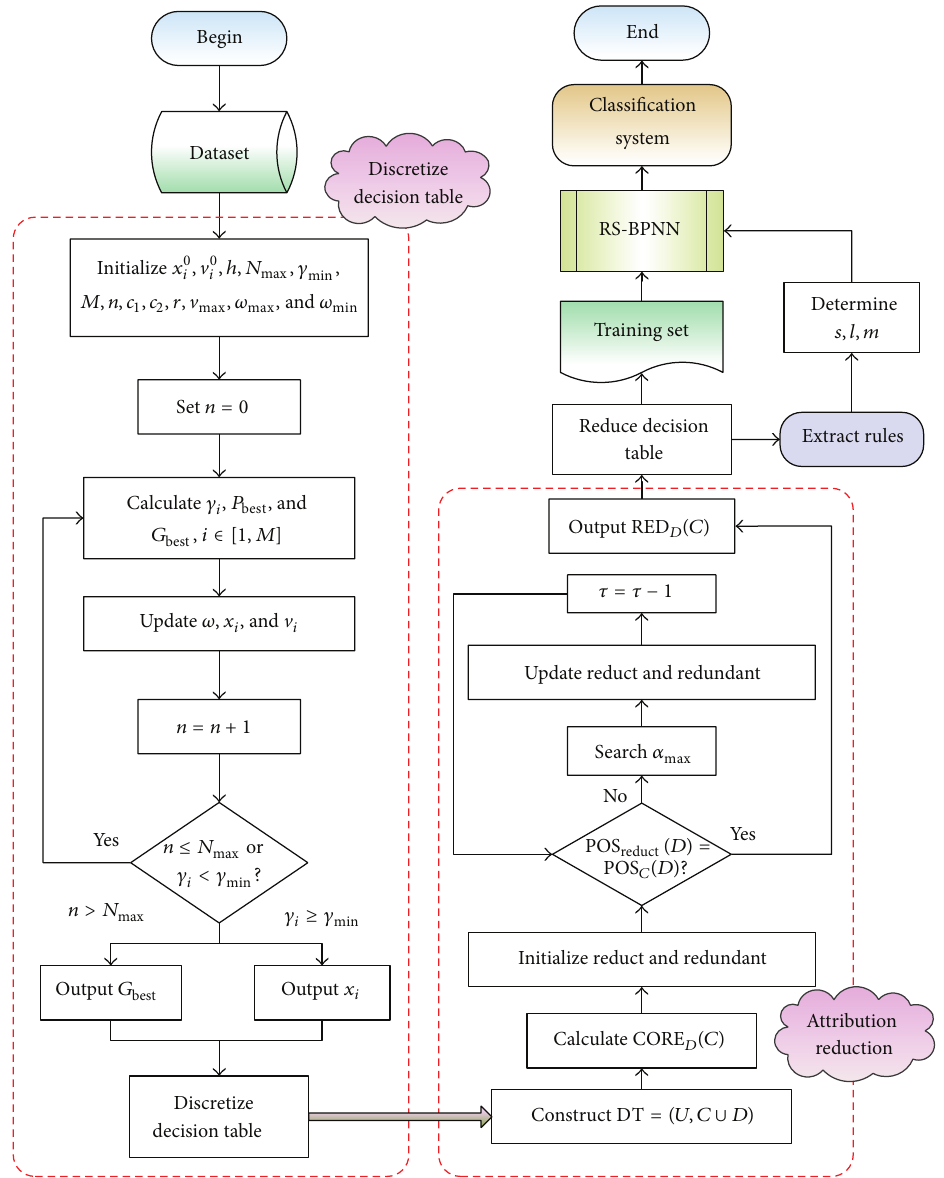
Figure 3: The flowchart of the proposed